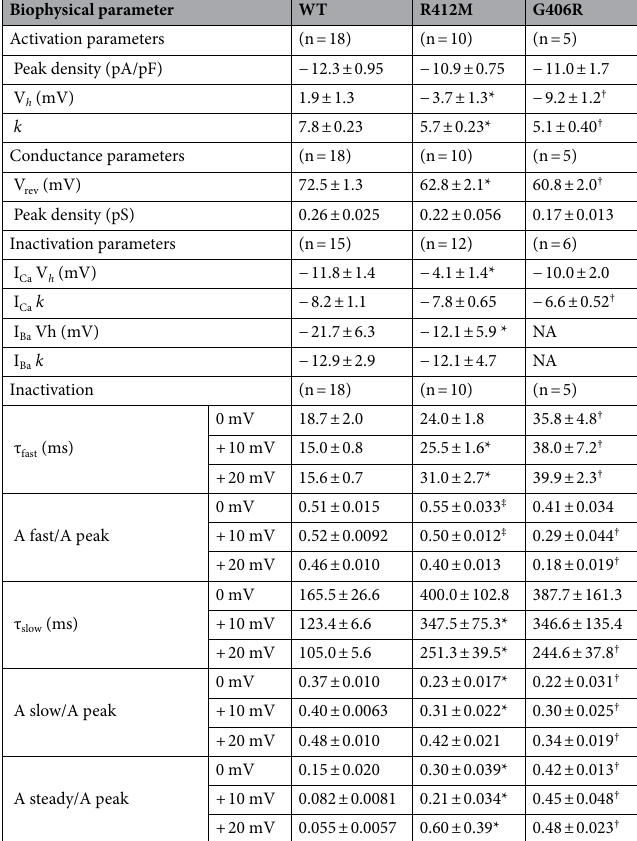
Table 1. Biophysical parameters of Ca v 1.2 WT, R412M and G406R channels. Peak current density of activation was measured at + 20 mV for WT and at + 10 mV for R412M. Peak conductance was measured at + 40 mV. NA not available. * P < 0.05 R412M versus WT. † P < 0.05 G406R versus WT. ‡ P < 0.05 R412M versus